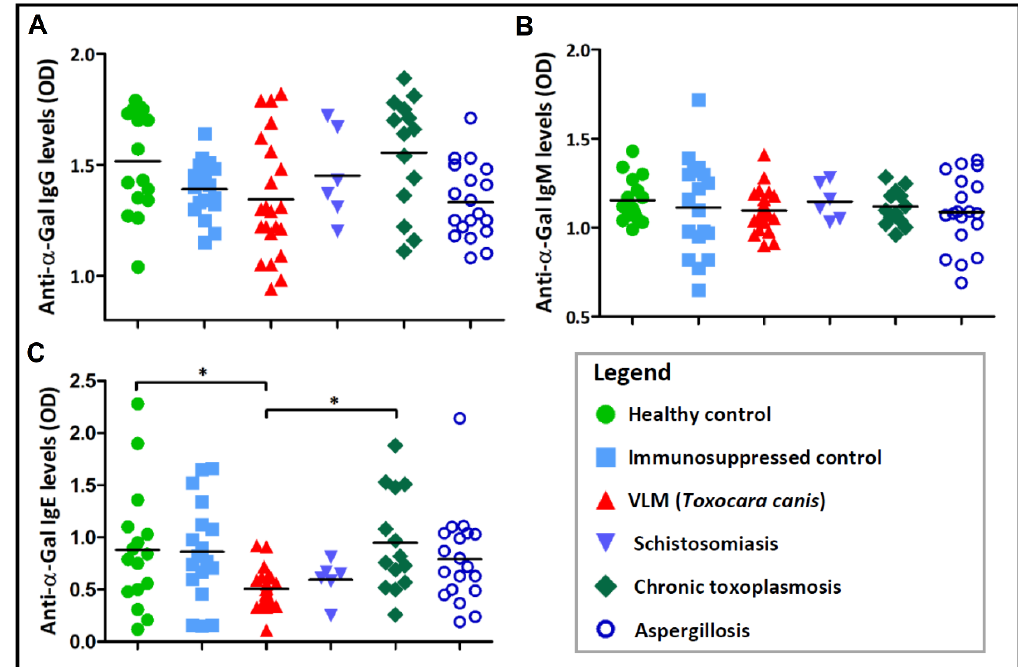
Figure 5. Reactivity of ( A ) IgG, ( B ) IgM, and ( C ) IgE antibodies to α -Gal in patients with schistosomiasis, chronic toxoplasmosis, aspergillosis, and visceral larva migrans (VLM) caused by Toxocara canis as measured by indirect ELISA. Sera from healthy and immunosuppressed individuals were included as controls. One-way ANOVA with Dunnett’s multiple comparison test was applied for individual comparisons of antibody levels to the control groups, and the Kruskal–Wallis test with Dunn’s posthoc test was used to test the differences between the infected groups. Only statistically significant differences are indicated: * p < 0.05.